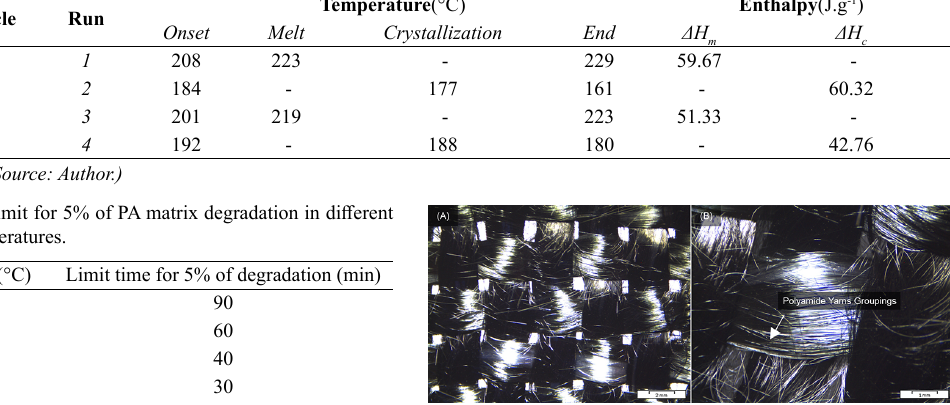
Figure 4. Stereoscope images of CF/PA commingled fabric features. (A) Plain weave commingled fabric. (B) Grouping of PA yarns.